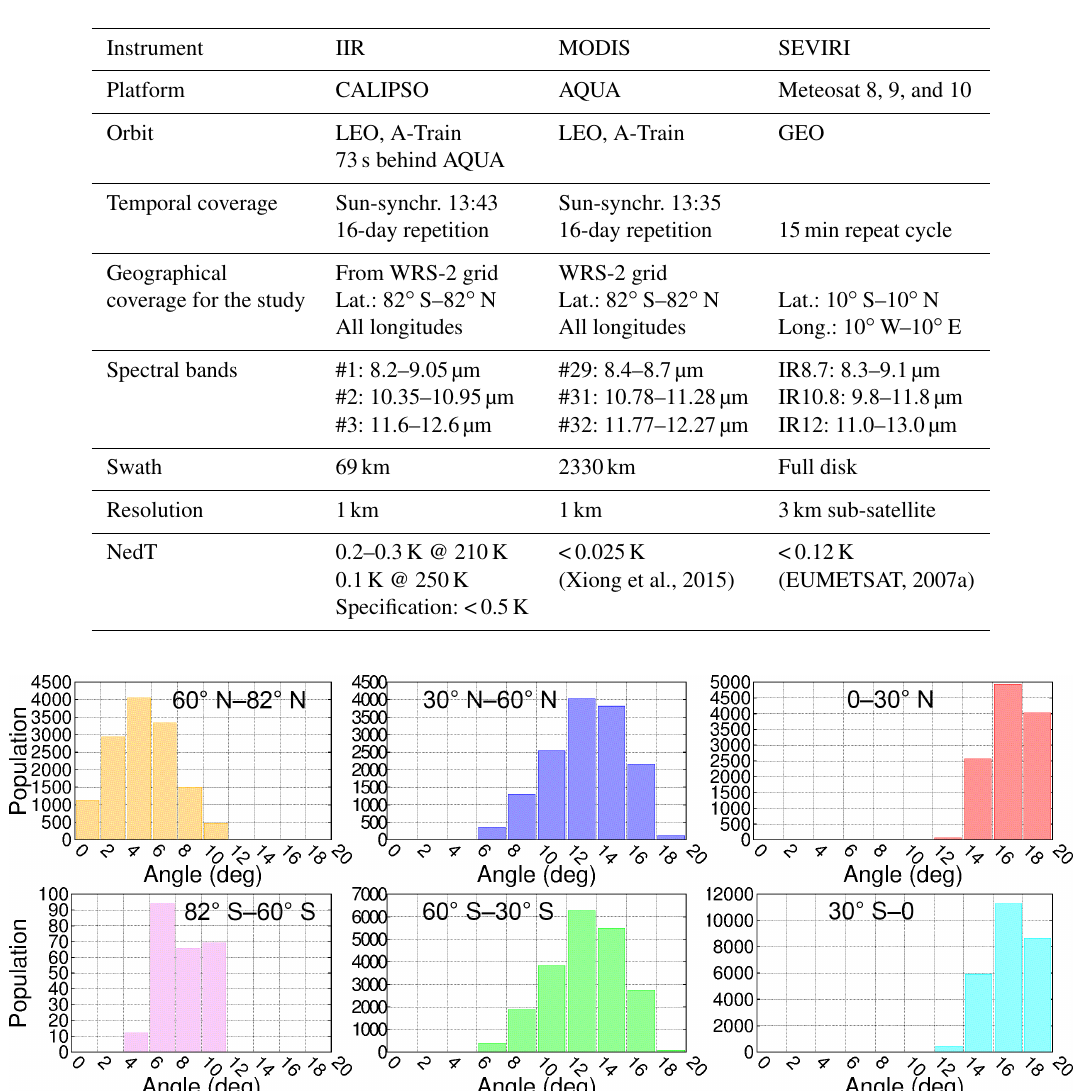
Table 1. Main characteristics of the instruments and channels considered for this study.